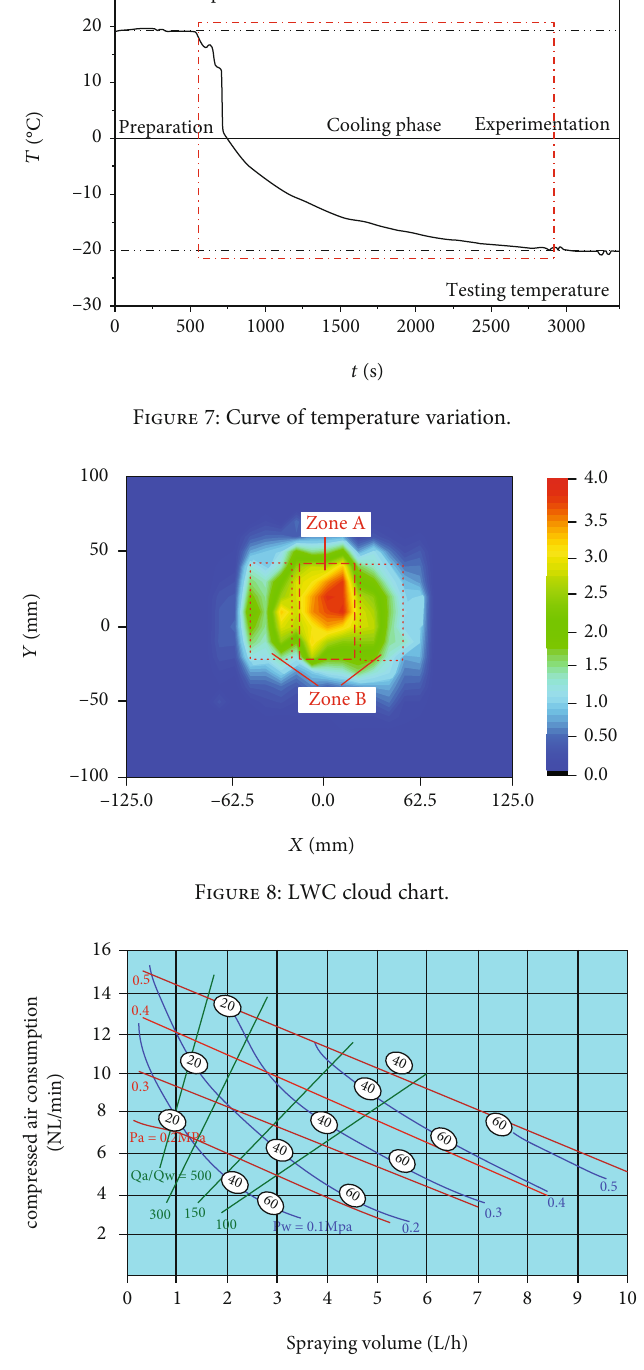
Figure 9: Characteristic curve of